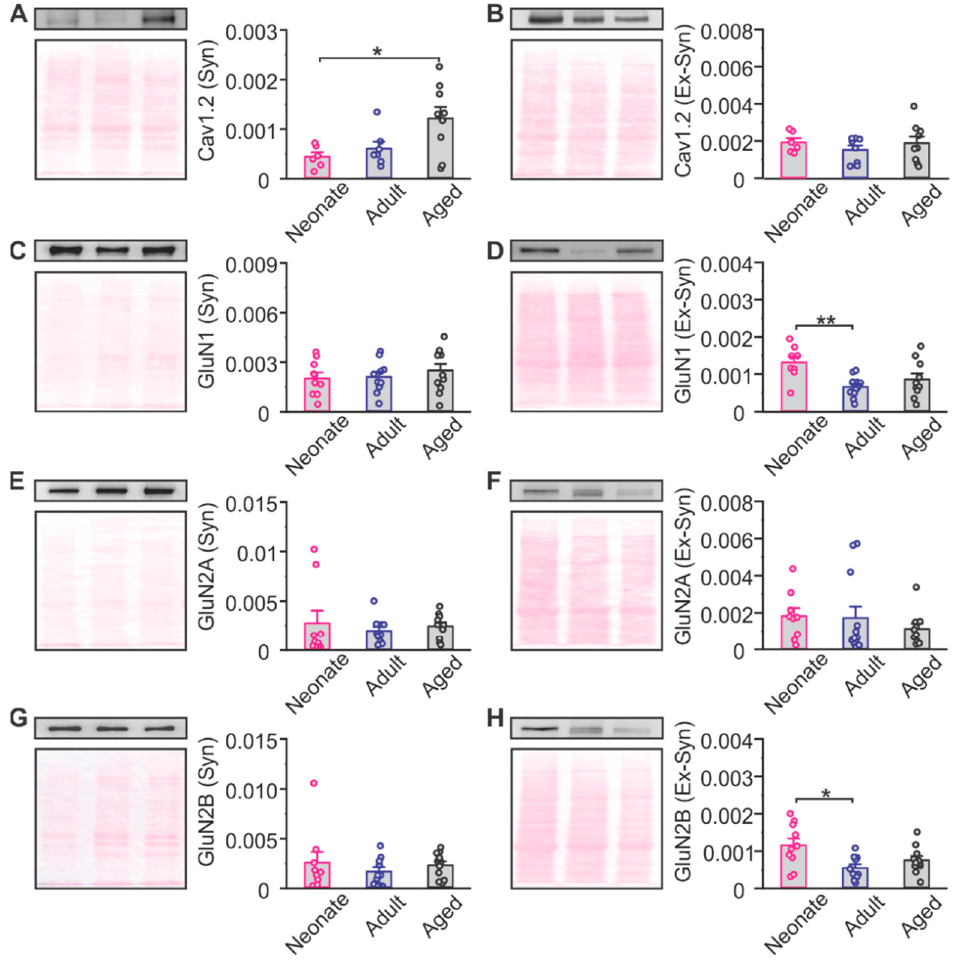
Figure 4. Age-dependent calcium permeable channel expressions in the piriform cortex. ( A ) Synaptic expressions of L-type calcium channel Cav1.2 subunit. Neonate: n = 6; Adult: n = 7, Aged: n = 9. ( B ) Extra-synaptic expressions of Cav1.2 subunit. Neonate: n = 6; Adult: n = 8, Aged: n = 9. ( C ) Synaptic expressions of NMDAR GluN1 subunit. Neonate: n = 9; Adult: n = 10, Aged: n = 11. ( D ) Extra-synaptic expressions of GluN1 subunit. Neonate: n = 8; Adult: n = 11, Aged: n = 10. ( E ) Synaptic expressions of NMDAR GluN2A subunit. Neonate: n = 9; Adult: n = 10, Aged: n = 10. ( F ) Extra-synaptic expressions of GluN2A subunit. Neonate: n = 9; Adult: n = 12, Aged: n = 10. ( G ) Synaptic expressions of NMDAR GluN2B subunit. Neonate: n = 9; Adult: n = 10, Aged: n = 11. ( H ) Extra-synaptic expressions of GluN2B subunit. Neonate: n = 10; Adult: n = 10, Aged: n = 11. * p < 0.05; ** p < 0.01.